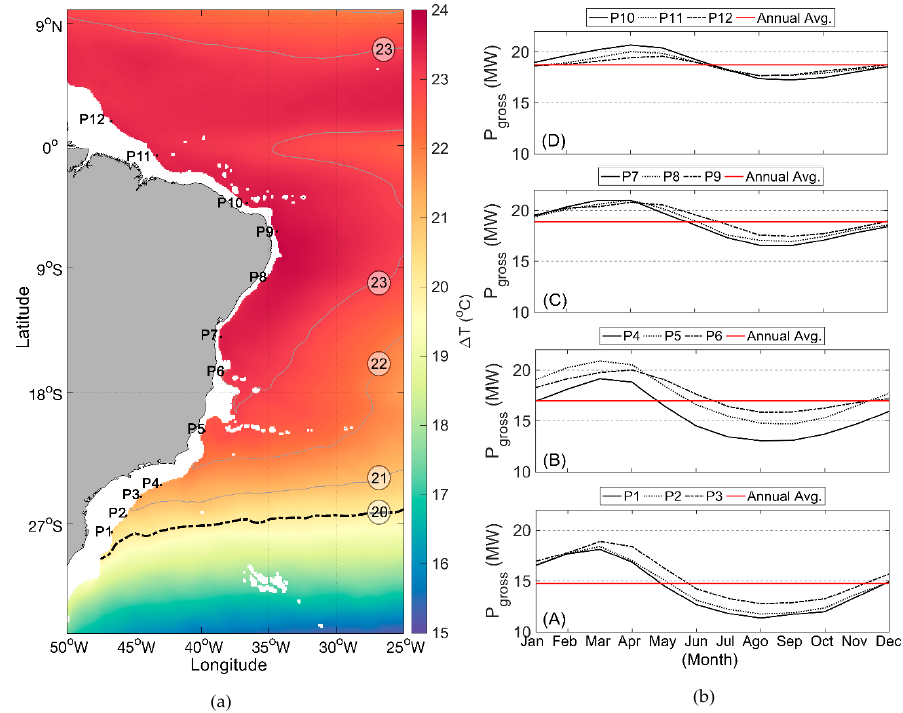
Figure 16. ( a ) Annual mean Δ T (°C) between 20 and 1000 m and ( b ) the annual ocean thermal energy conversion (OTEC) Gross Power Density (P G in MW) at a depth of 1000 m considering the period between January 1, 2007 and December 31, 2017. Table 6. Gross and net power estimation for the selected points along the Brazilian coastline. Regions Points